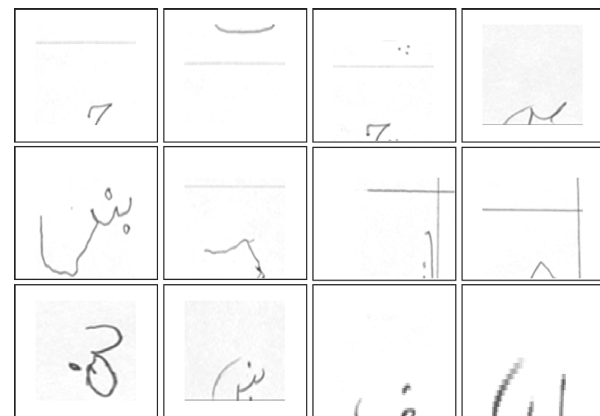
Figure 6: Ambiguous character